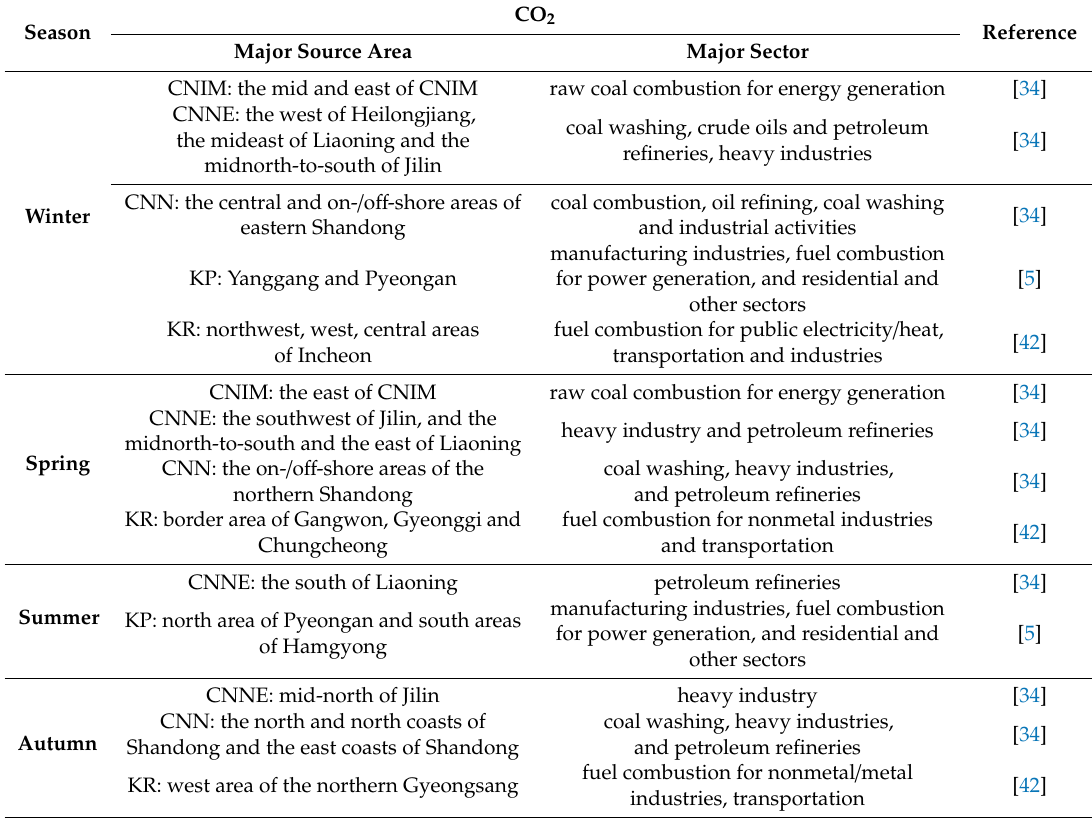
Table 3. Summary of the major source areas for CO 2 identified by the CWT